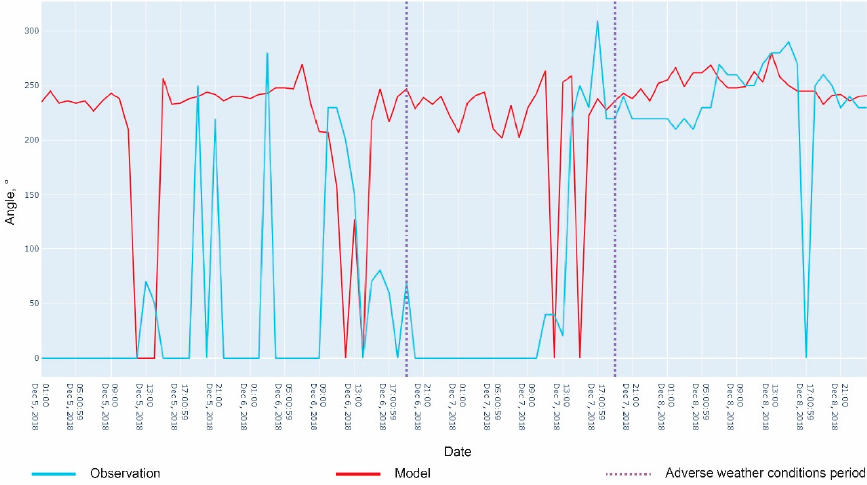
Figure 11. Simulated and observed wind directions (meteorological on code 29570).